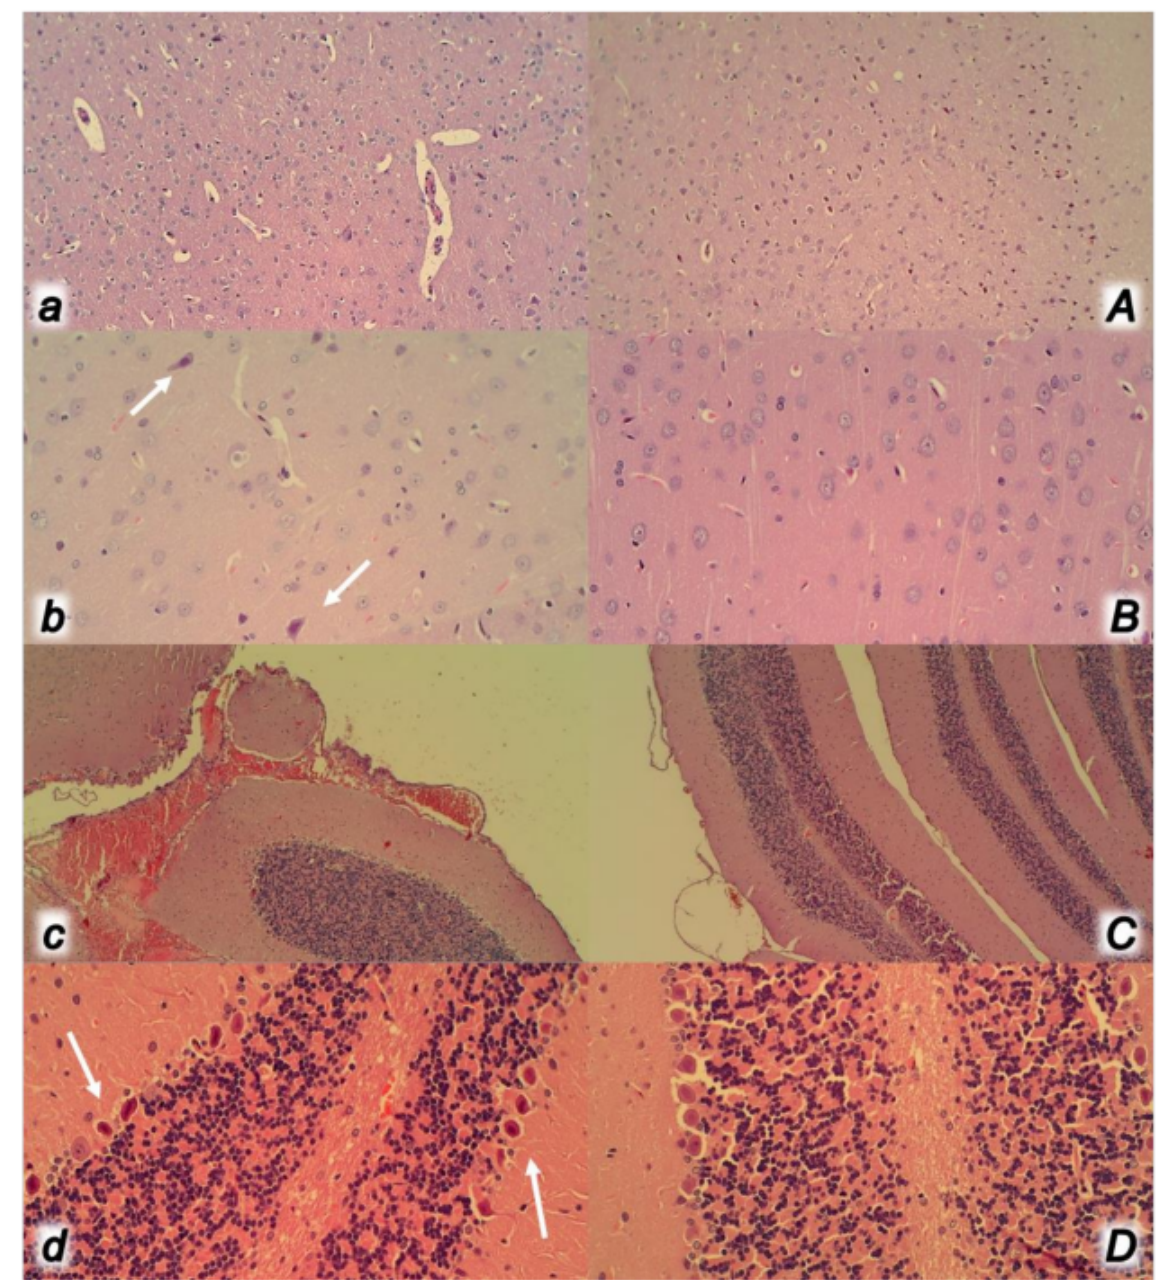
Figure 13. At 30 min ligation-time, microscopy presentation of the neuropathologic changes in the cerebral cortex ( a , A (HE, × 200), b , B (HE, × 400)) and cerebellar cortex ( c , C (HE, × 100), d , D (HE, × 400)) areas of the rats with occluded superior mesenteric vein and artery, controls (small letters) and BPC 157 treated (capitals). Cerebral cortex ( a , A , b , B ). While control rats with occluded superior mesenteric vein and artery exhibited marked edema and congestion ( a ), BPC 157 treated rats presented only mild edema ( A ). A scant karyopyknosis presented control rats with occluded superior mesenteric vein and artery in the cerebral cortex (arrows) ( b ) while no changes appeared in BPC 157 treated rats ( B) . Cerebellar cortex ( c , C , d , D ). Control rats with occluded superior mesenteric vein and artery exhibited subarachnoid hemorrhage at the base of the brain in the cerebellar area ( c ) and multiple karyopyknosis of Purkinje cells of the cerebellar cortex (arrows) ( d ), unlike BPC 157 treated rats which remained without change ( C , D